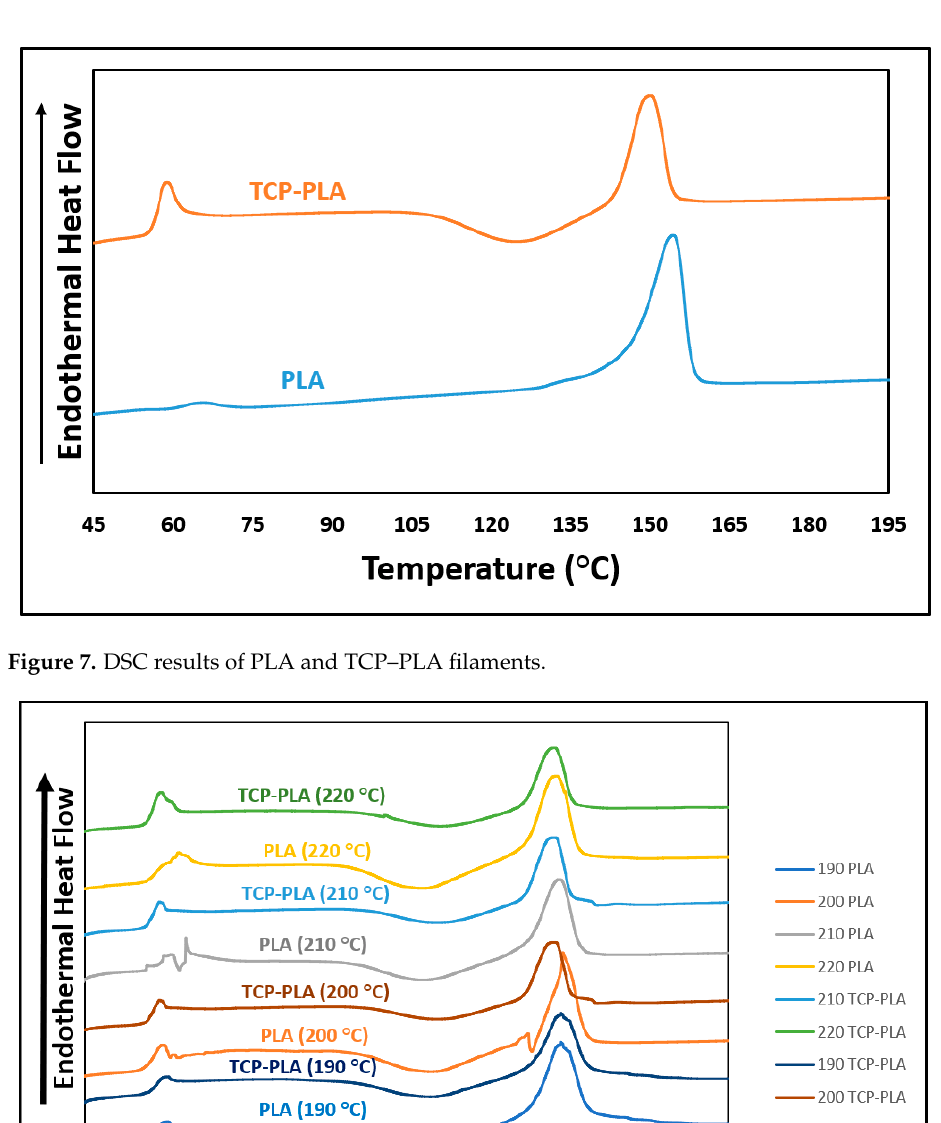
Figure 8. DSC results of PLA and TCP–PLA samples printed at different nozzle temperatures.